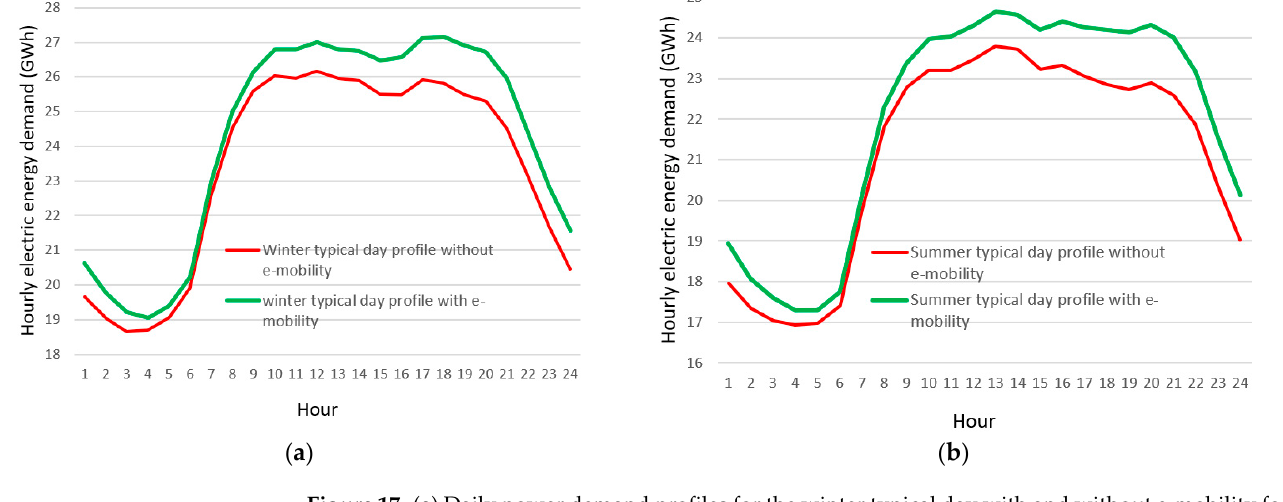
Figure 17. ( a ) Daily power demand profiles for the winter typical day with and without e-mobility for the balanced variant of the number of EVs in 2027; ( b ) Daily power demand profiles for the summer typical day with and without e-mobility for the balanced variant of the number of EVs in